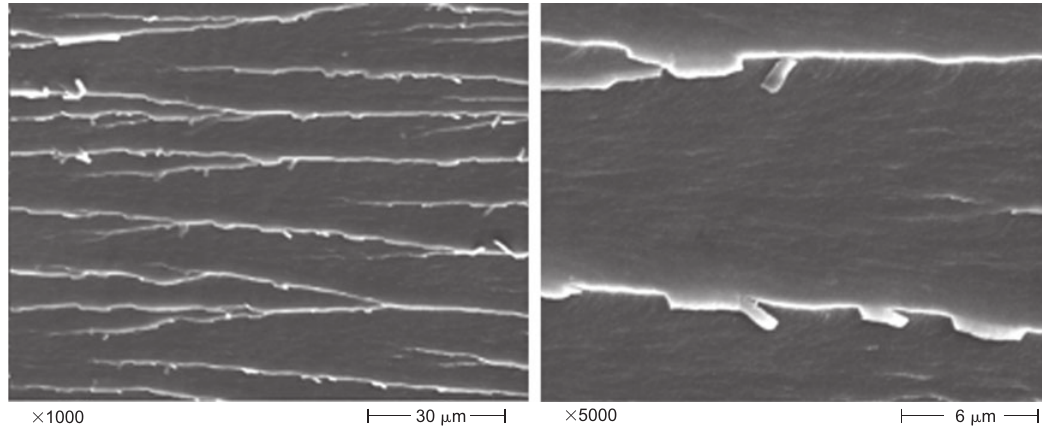
Figure 4 SEM pictures from fracture surface of RTM6 ® + 10 wt %